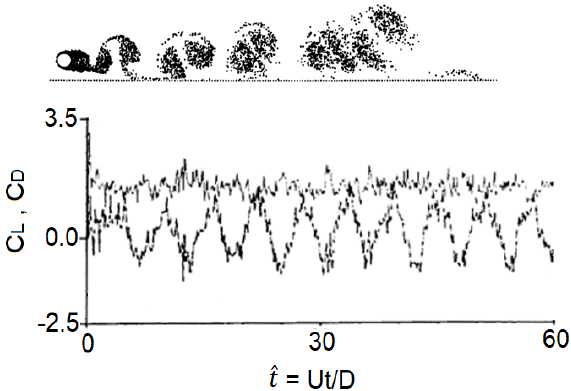
Figure 13. The flow pattern and force coefficients for G/D = 1 and Re = 500.